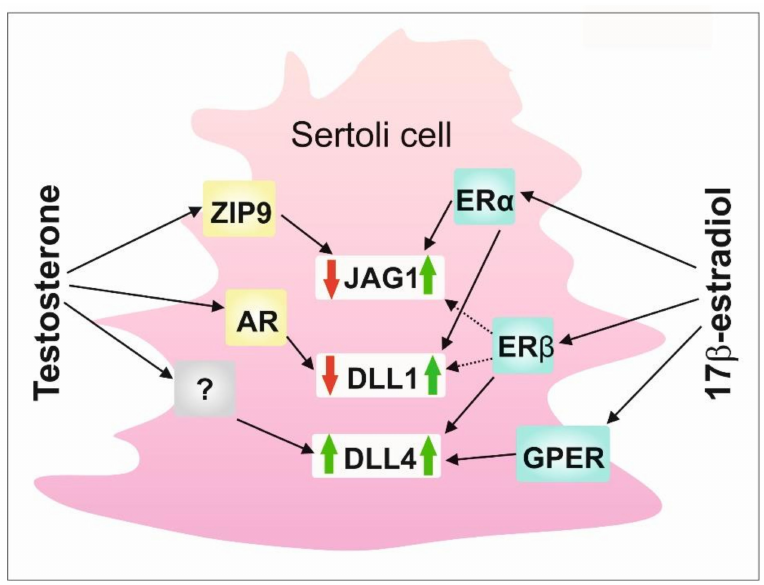
Figure 5. A schematic model of the regulation of DSL proteins by sex steroids and their receptors in rodent Sertoli cells. AR—nuclear androgen receptor; DLL1—Delta-like 1; DLL4—Delta-like 4; ER α —estrogen receptor α ; ER β —estrogen receptor β ; GPER - G protein-coupled estrogen receptor; JAG1—Jagged1; ZIP9—ZRT-and Irt-like protein